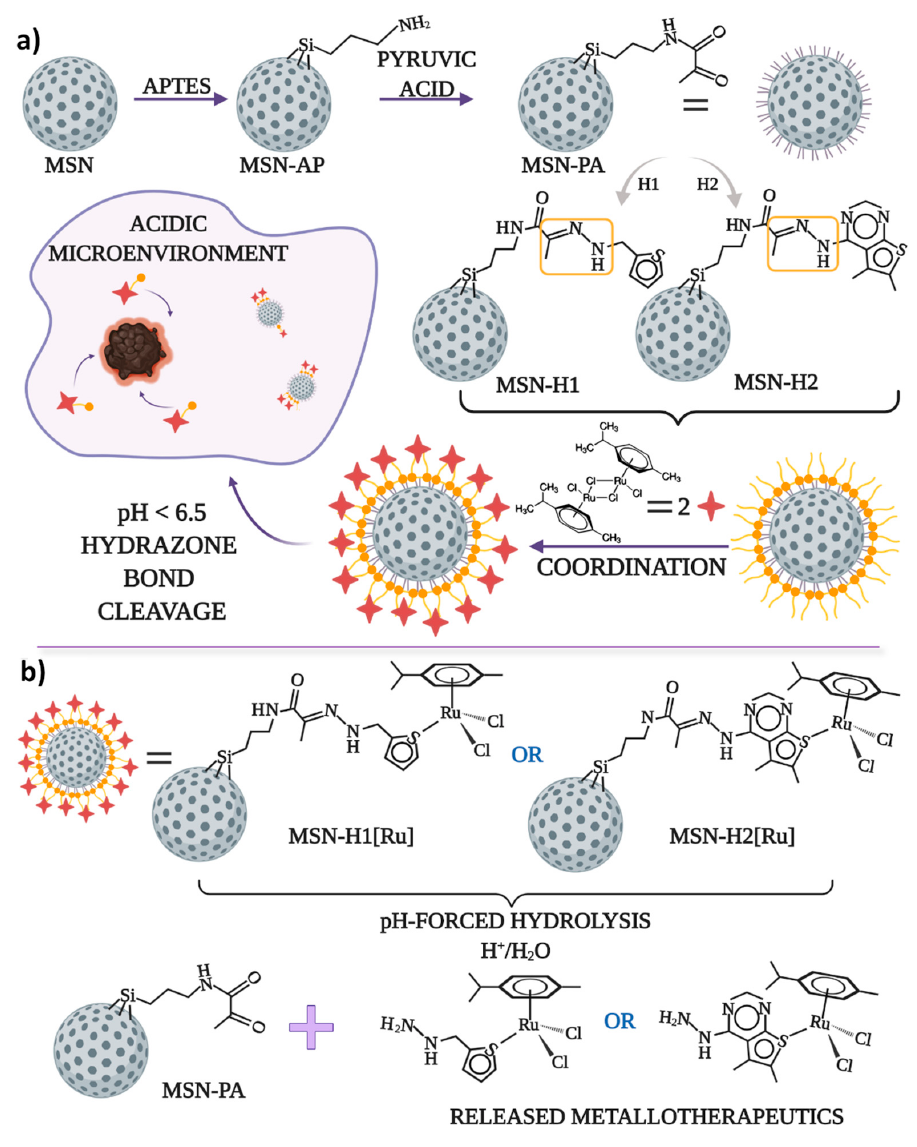
Figure 1. The schematic representation of ( a ) the synthesis process of the anticancer drug delivery systems for pH-responsive delivery of the cytotoxic ruthenium(II) complexes and ( b ) pH-forced hydrolysis of MSN-H1[Ru] and MSN-H2[Ru] and proposed structures of released metallotherapeutics.